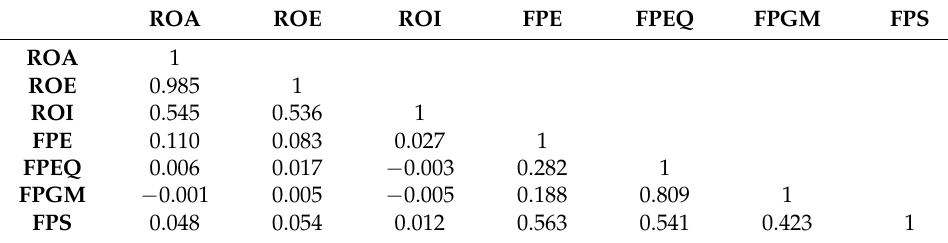
Table 9. The correlation matrix for energy